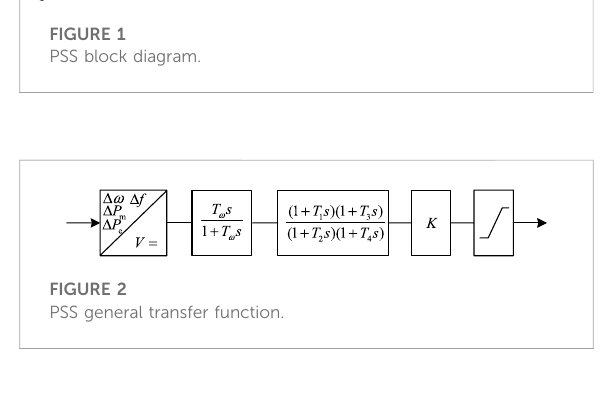
FIGURE 1 PSS block diagram.